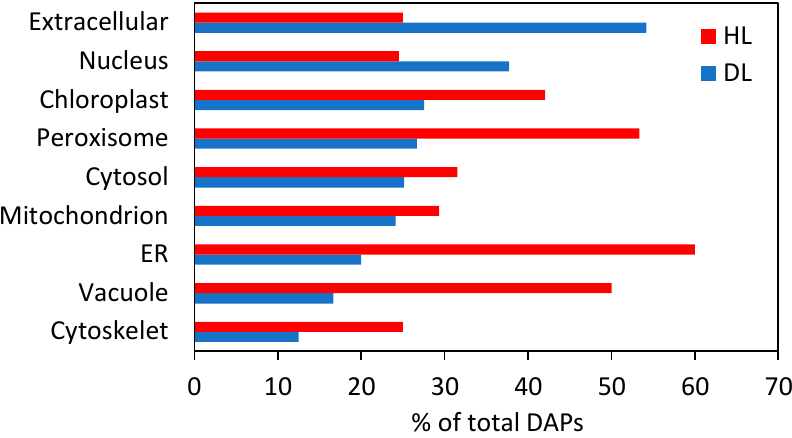
Figure 2. Predicted subcellular localization of DAPs in R. serbica HL and DL.